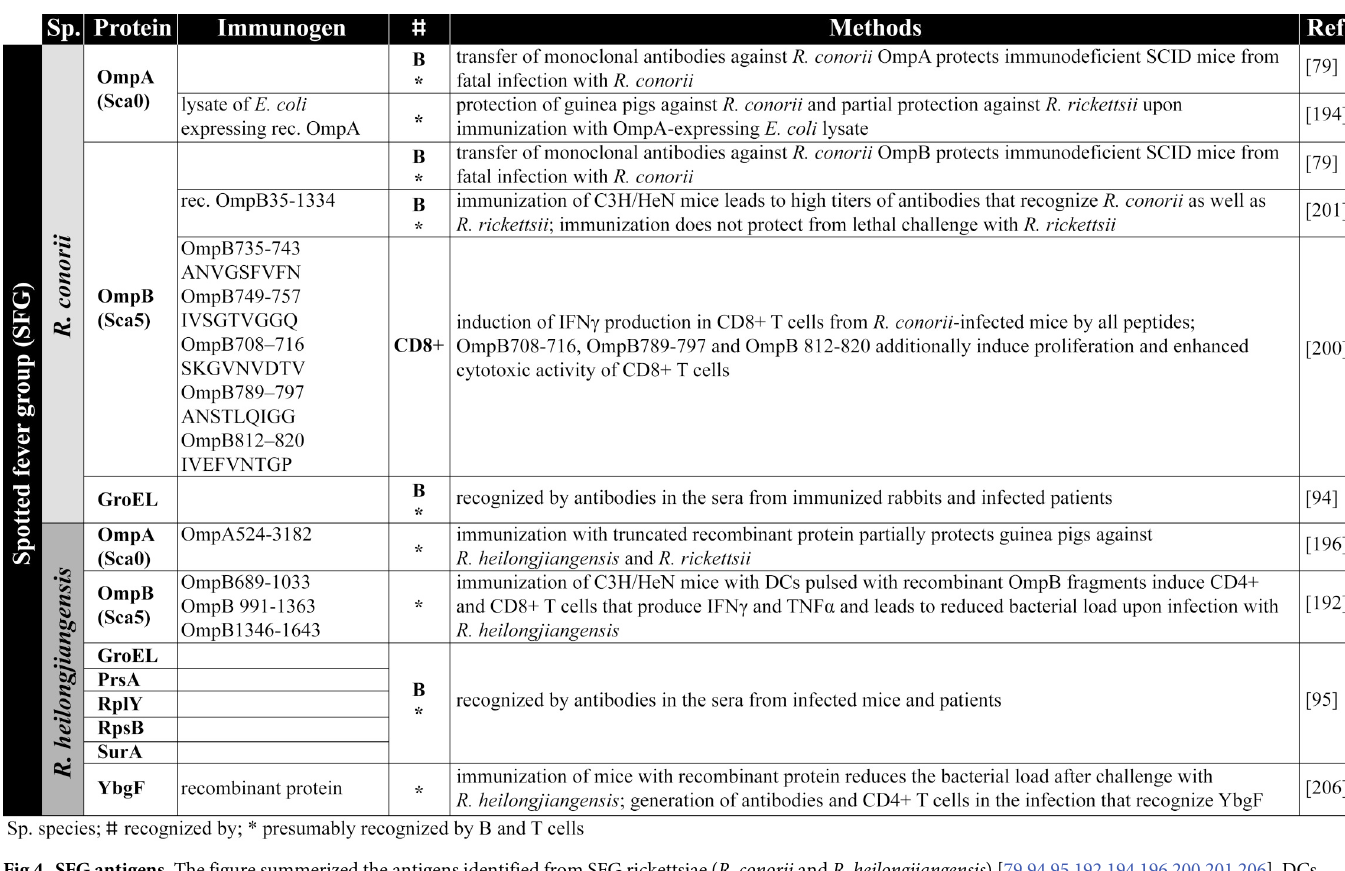
Fig 4. SFG antigens. The figure summerized the antigens identified from SFG rickettsiae ( R . conorii and R . heilongjiangensis ) [79,94,95,192,194,196,200,201,206]. DCs, dendritic cells; IFN γ , interferon gamma; SFG, spotted fever group; TNF α , tumor necrosis factor